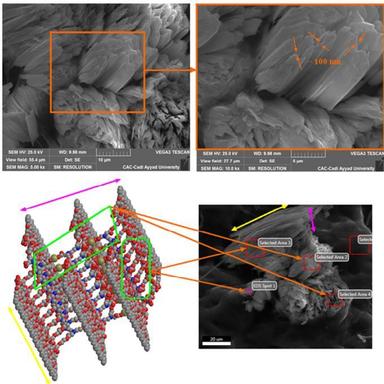
Nano-encapsulated Pb (II) in BEC-EDTA showed by SEM images and the self-assembly proposed structure